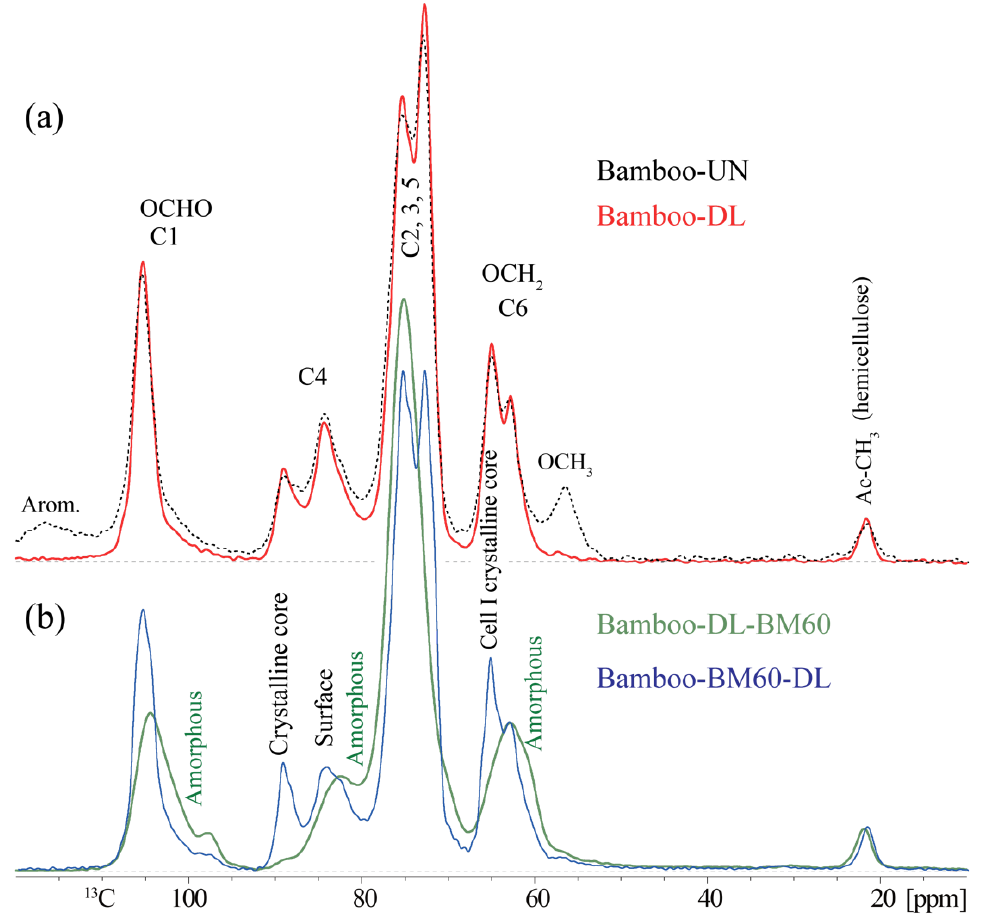
Figure 2. Cross polarization 13 C NMR spectra of sp 3 -hybridized C in ( a ) bamboo-UN and bamboo-DL; ( b ) bamboo-DL-BM60 and bamboo-BM60-DL. Table 1 provides descriptions of these samples.